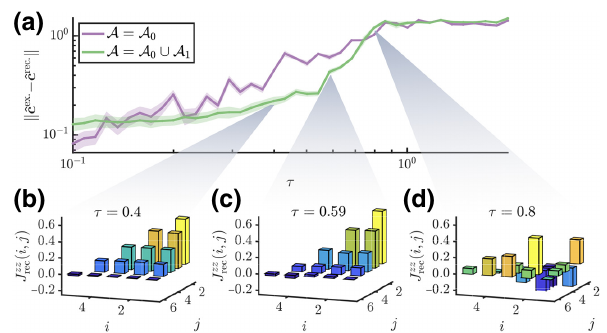
FIG. 5. FHL for the DQS of the Schwinger model. Numerical simulation of FHL applied to a DQS of the lattice Schwinger model with N = 6 qubits. Panel (a) shows the reconstruction error (cid:8)ˆ c ex − ˆ c rec (cid:8) as a function of τ for ansätze up to zeroth and first orders. The error bars stem from a finite measurement budget per operator n s = 10 3 . Panels (b)–(d) show the reconstructed zz interactions for several Trotter steps. Here we use time evolution of 100 random initial product states for final times T ∈ { 2, 3 } , yielding a total of 200 constraints for | A 0 ∪ A 1 | = 89